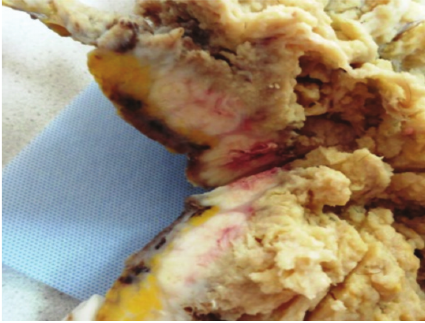
Figure 3: Tumor invasion of appendiceal serosa and muscularis propria (H&E ×